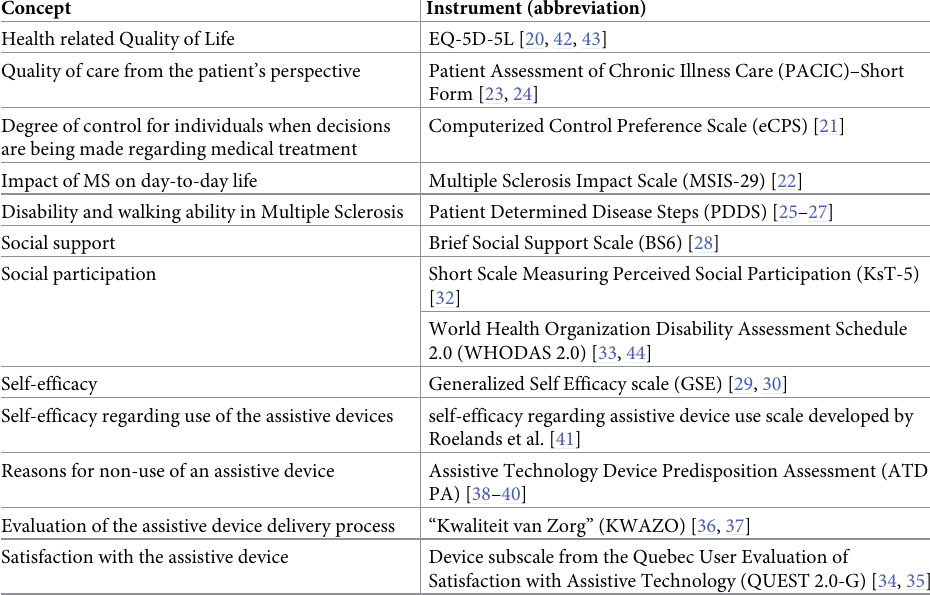
Table 2. Instruments used in the online